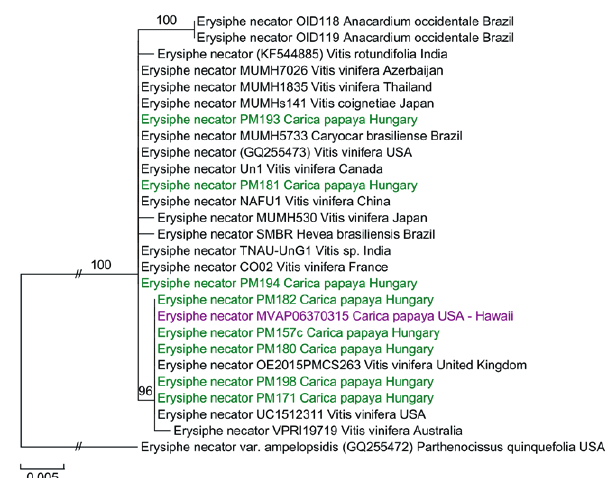
Figure 5. Phylogenetic tree with the greatest likelihood value resulting from the maximum likelihood (ML) analysis of ITS sequences of selected Erysiphe necator samples. Species names are followed by herbarium accession numbers (or GenBank accession numbers in paren- theses if herbarium accession number is not available), name of host plant, and country of collection. Samples collected in the present study are in green font, while other powdery mildew samples from papaya are in purple. Bootstrap values were calculated from 1000 replicates in ML analysis (values below 70% and in subclades are not shown). Bar indicates 0.005 expected changes per site per